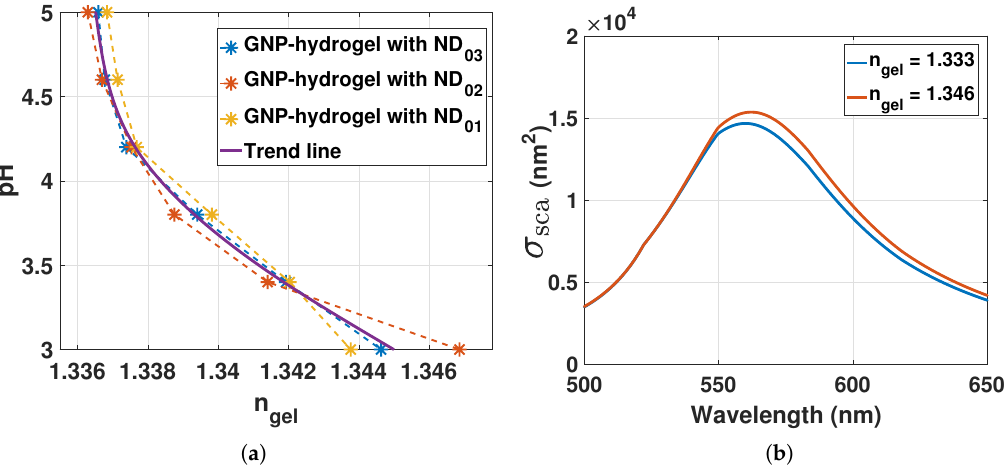
Figure 7. ( a ) RI of hydrogel computed from Equation (13) and (17) for pH 5 to 3; ( b ) scattering cross-section computed from Equation (1) with L = 1 for n m = n gel at 1.333 and